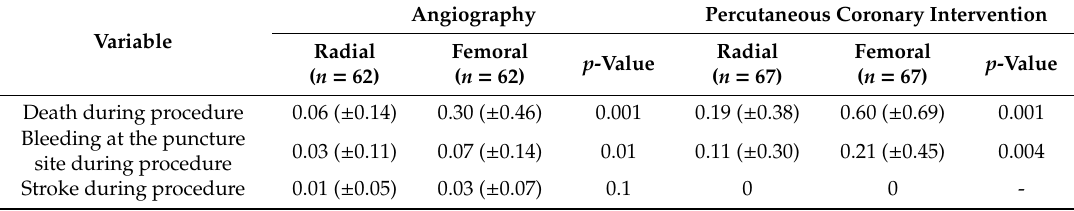
Table 8. Comparison of event rates between procedures with radial and femoral access site for stable angina and acute coronary syndrome in a group of operators performing 25–50% of procedures with radial